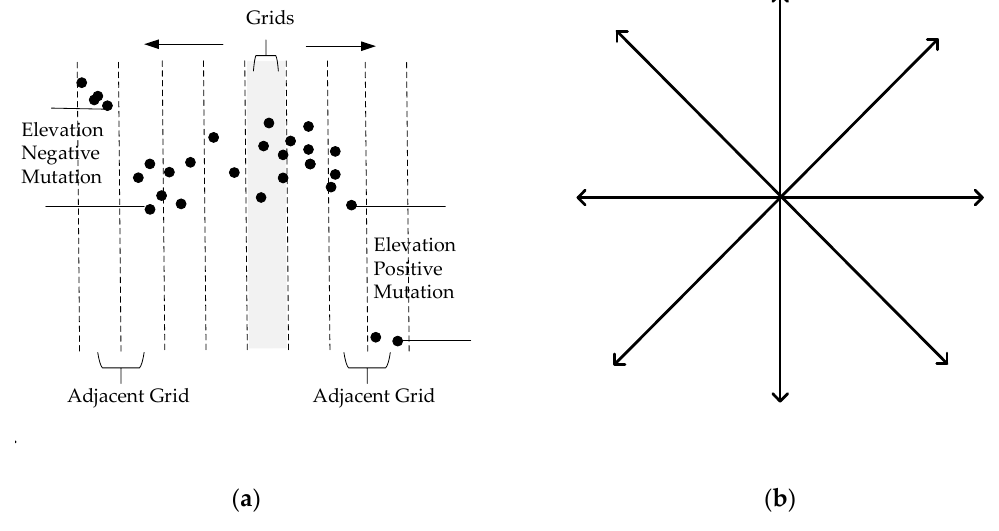
Figure 3. Altitude jump. ( a ) front view; ( b ) top view.